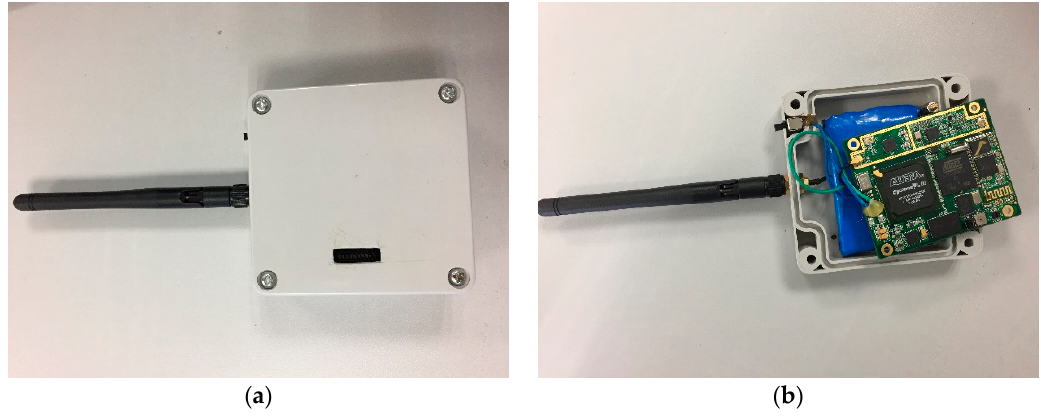
Figure 15. The positioning receiver: ( a ) appearance and ( b ) internal structure.